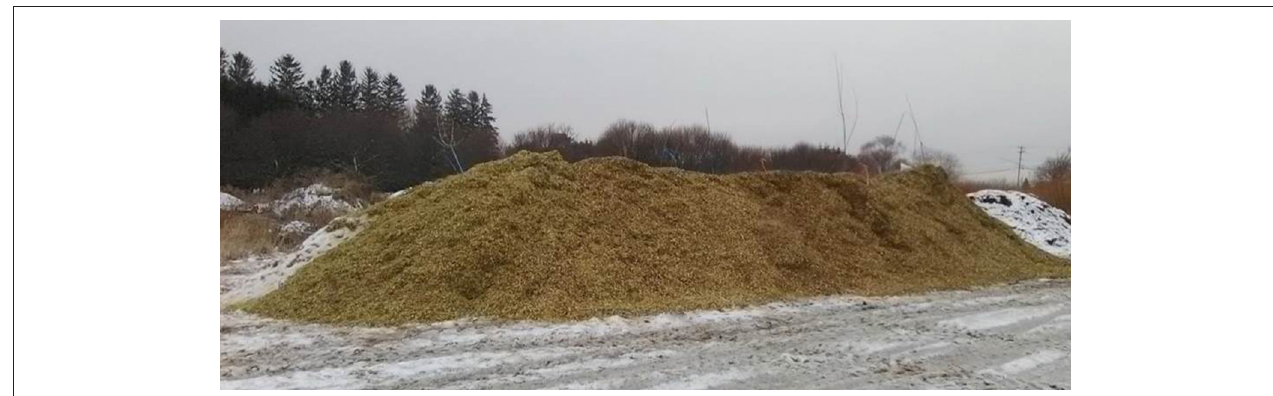
FIGURE 1 | A winter storage pile of willow chips created at an experimental field station in Tully,